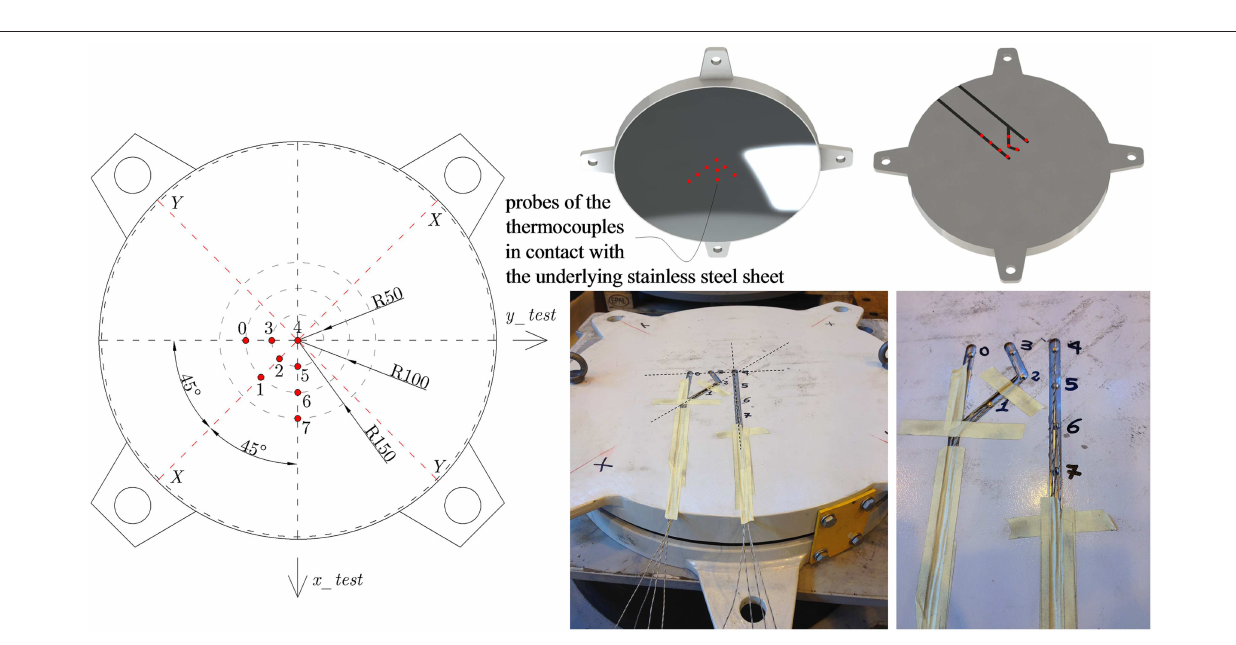
FIGURE 5 | Preparation of the DCSS prototype with eight thermocouples embedded into the upper